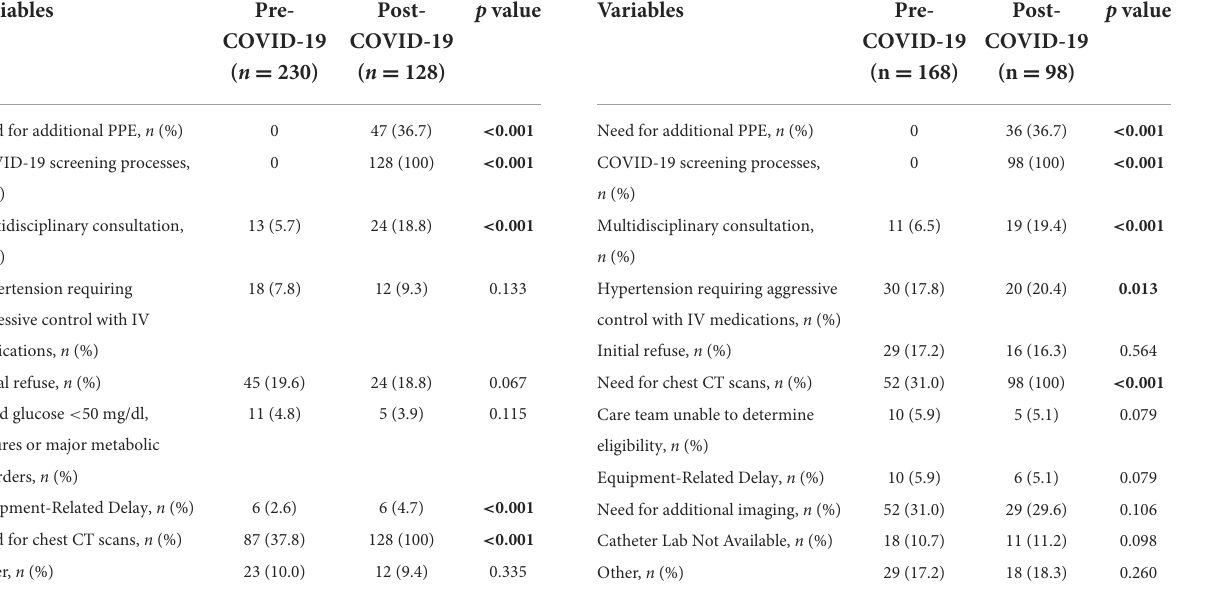
TABLE 3 Influencing factors for delayed intravenous thrombolysis treatment.